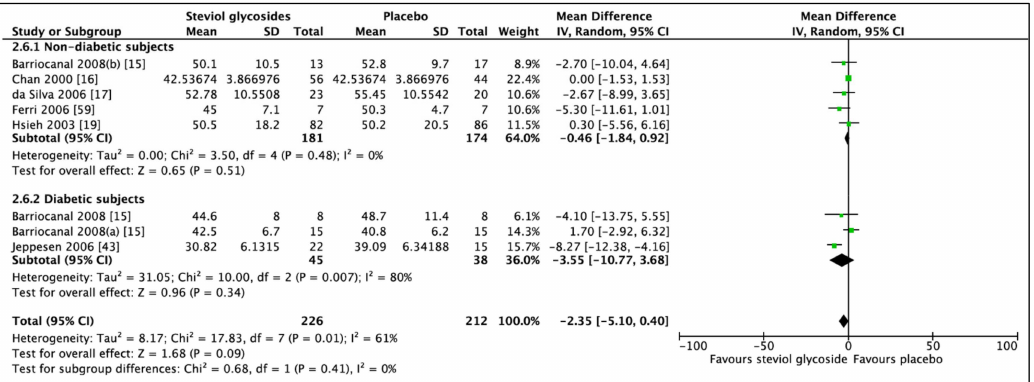
Figure 9. E ff ect of SGs on low-density lipoprotein cholesterol (LDL-C, mg / dL) CI: confidence interval; MD: mean di ff erence; RCTs: randomized controlled trials; SD: standard deviation.